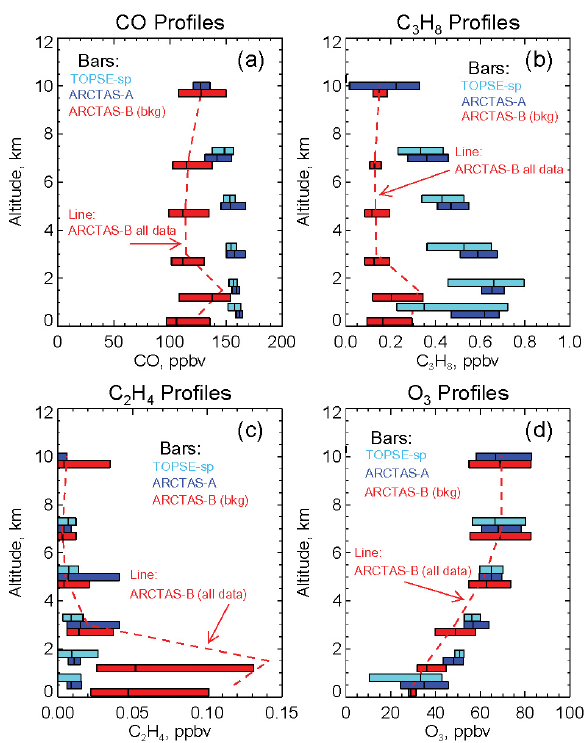
Fig. 3. Profiles of measurements of (a) CO, (b) C 3 H 8 (c) C 2 H 4 and (d) O 3 during ARCTAS and during TOPSE-sp. Bar plots are as described in Fig. 2. Data for ARCTAS-B shown by the bar plots exclude values identified as within fresh plumes. The dashed lines show the median profile for ARCTAS-B when all data are consid- ered (including fresh plumes).